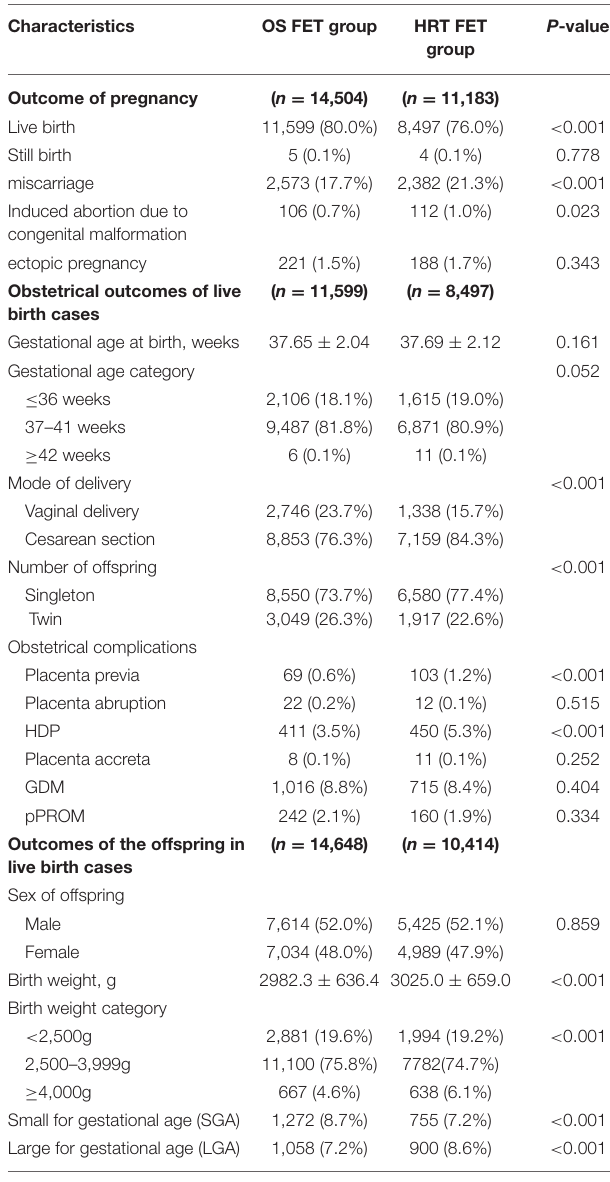
TABLE 2 | Pregnancy outcomes of OS FET and HRT FET